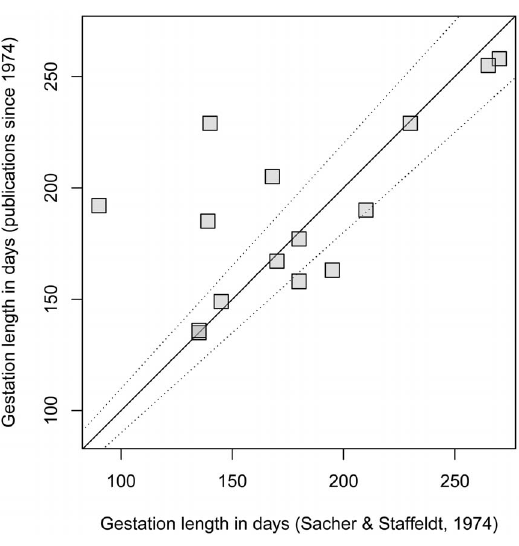
Figure 1. Gestation lengths for 15 nonhuman primates in 1974 and today. If past and present values were identical they would fall on the solid line (y=x). Points between the dotted lines indicate more recent values that are between 90% to 110% of the 1974 value. Data from Table 1.